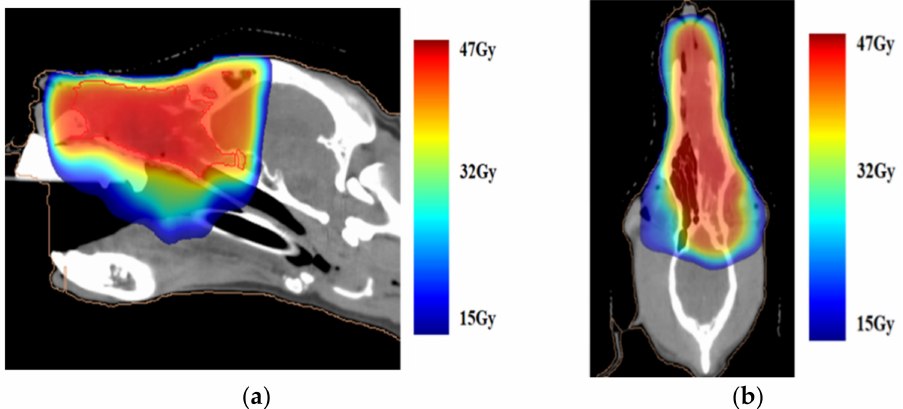
Figure 2. ( a ) Sagittal and ( b ) horizontal images prior to radiation therapy overlayed with the dose color wash. The whole nasal cavity is reserved for a total dose of 47